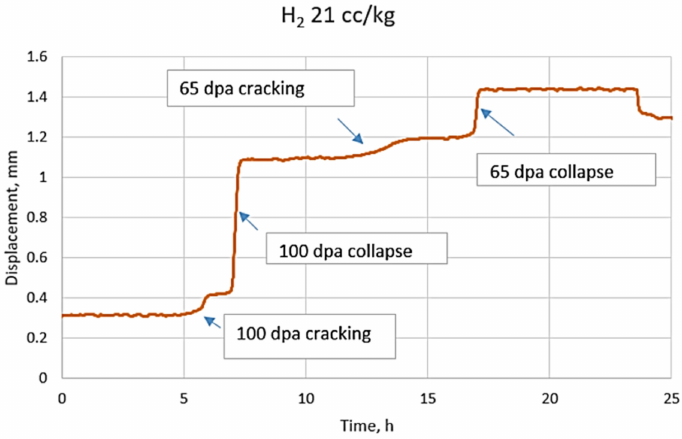
Figure 23. Load line displacement during the test in PWR water with lower dissolved hydrogen level (21